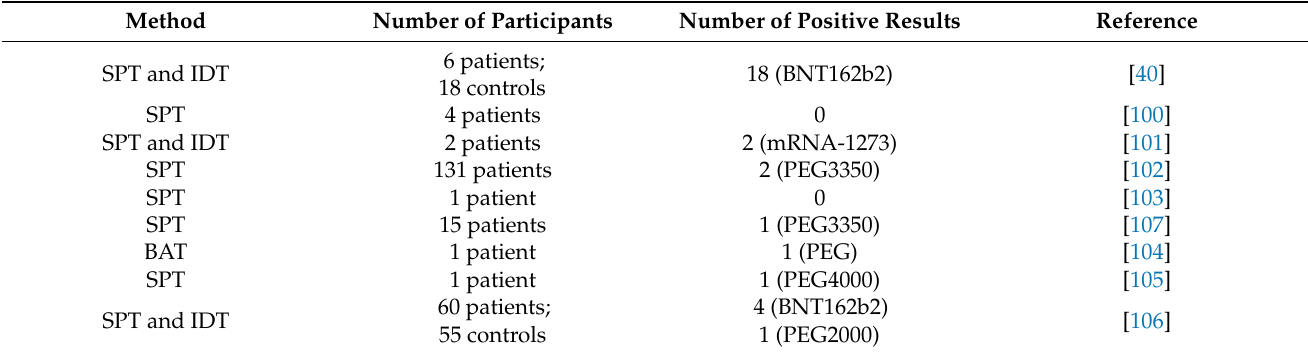
Table 3. Allergen testing in immediate hypersensitivity reactions by COVID-19